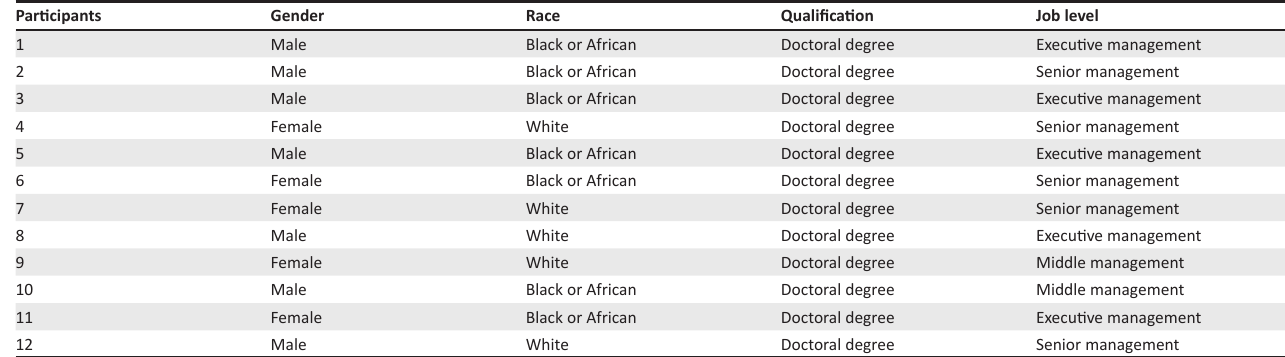
TABLE 1: Sample demographics.